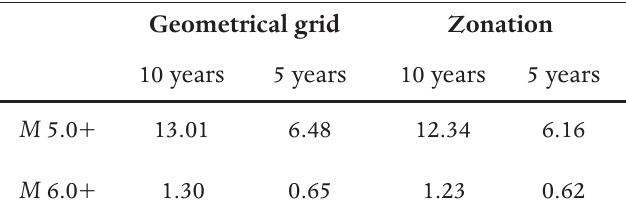
Figure 8. The number of expected events in the surface units of the CSEP testing grid for the seismotectonic zonation: left, M zonation has been drawn as a proxy.